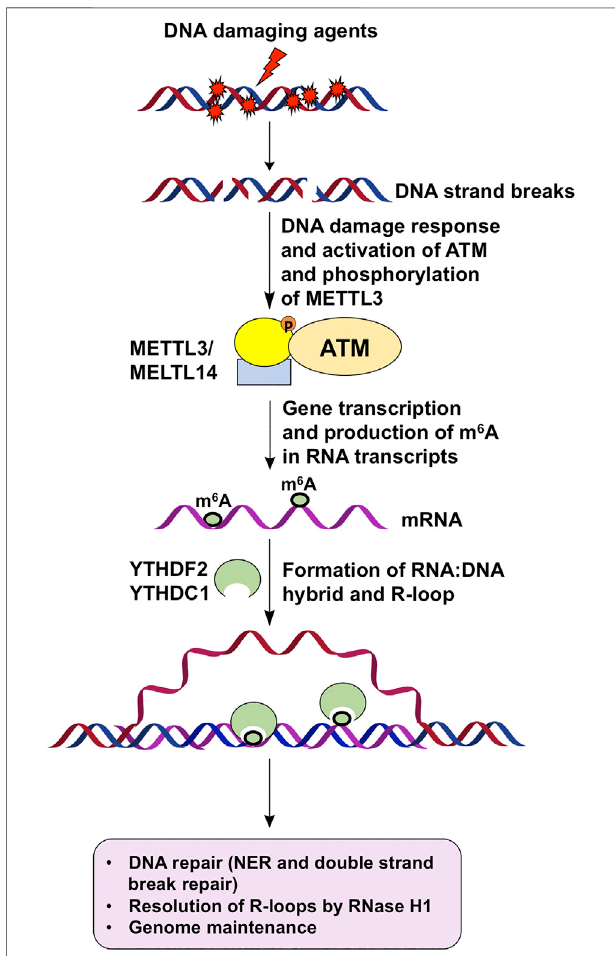
FIGURE 1 | m 6 A regulates DNA repair to maintain genome stability via R-loops. DNA damage agents induce strand breaks to activate DNA damage response and ATM, which phosphorylates and activates METTL3. DNA damage response then leads to gene transcription and production